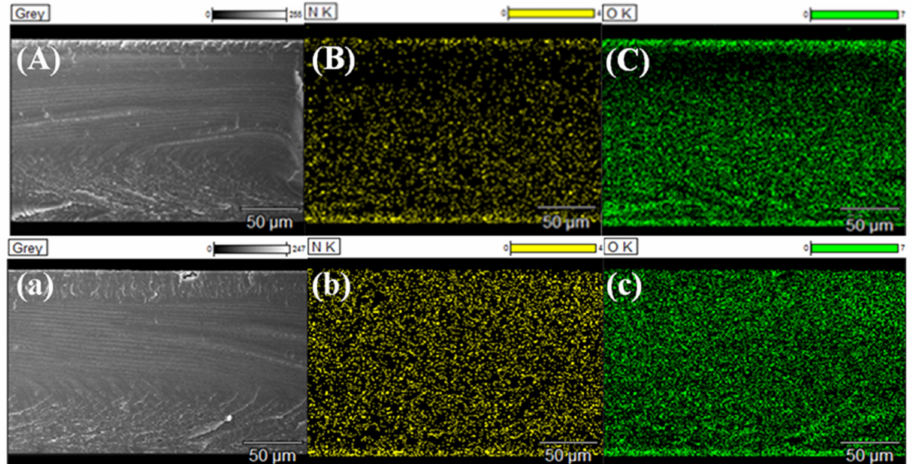
Figure 6. EDX elemental maps in the whole cross-section of modified membranes ( A ) M-PEI-12C4- 0.75 and ( a ) M-12C4-0.75-PEI (the bottom end of the section is the modified layer), ( B , b ) are the N element mapping and ( C , c ) are the O element